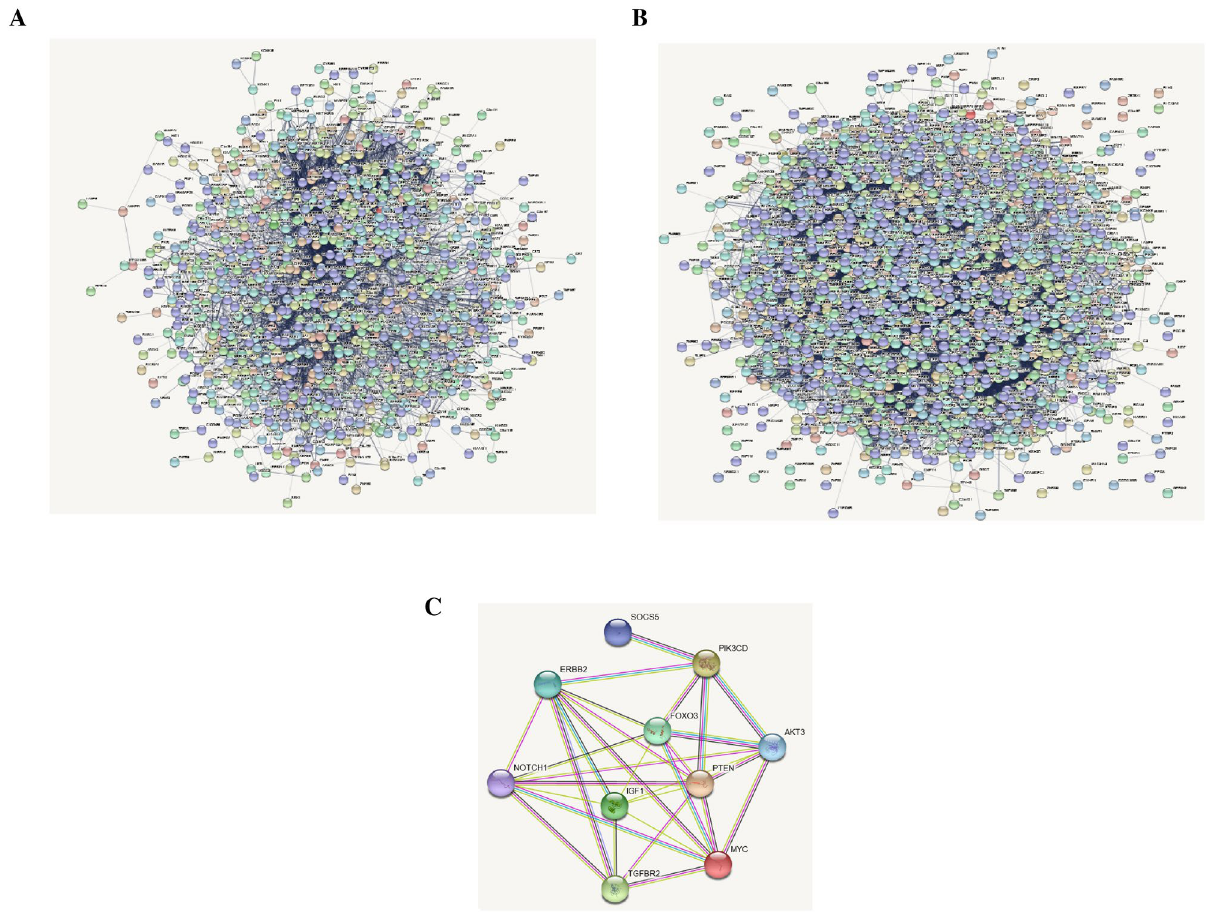
Figure 3. Protein–protein interaction (PPI) network. PPI network was constructed with the DEGs from the GEO and TCGA datasets. ( A , B ) The significant interactions were identified from the PPI network using the STRING database with a score of ≥ 7. ( A ) the interaction of up-regulated genes, ( B ) the interaction of down- regulated genes, and ( C) the interaction between up-and-downregulation